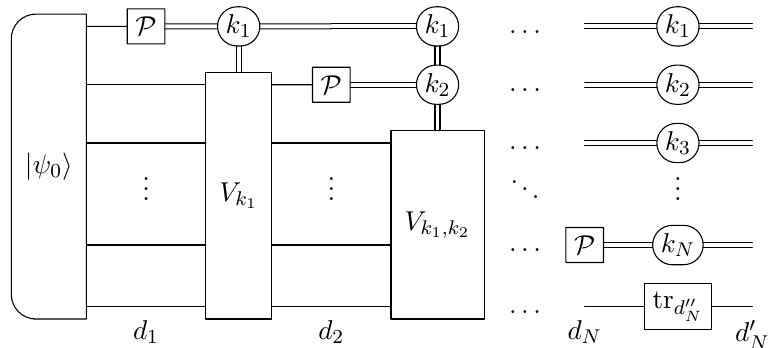
) on N copies of a von Neumann measurement P where ·